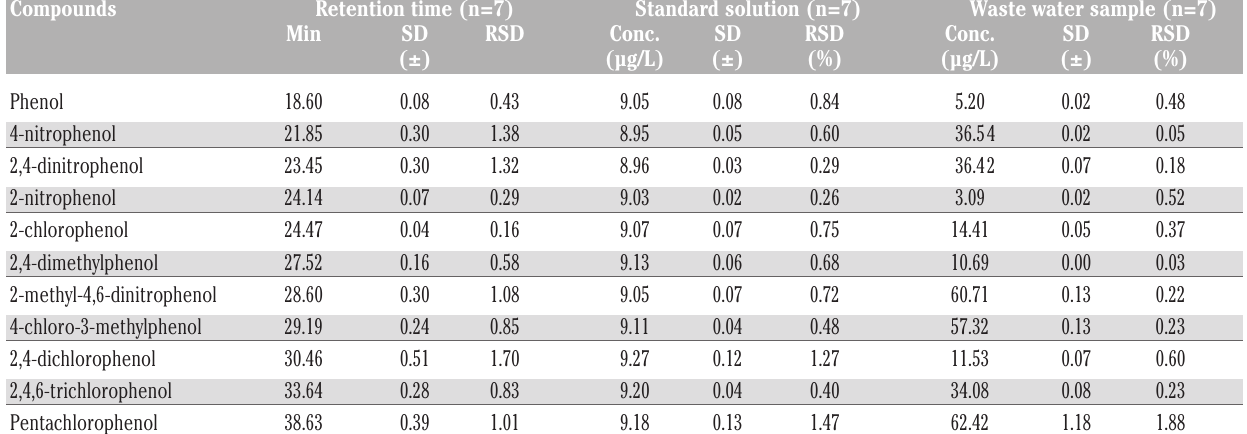
Table 6. Precision as repeatability of the method based on the retention time and concentration in standard solution and wastewater.